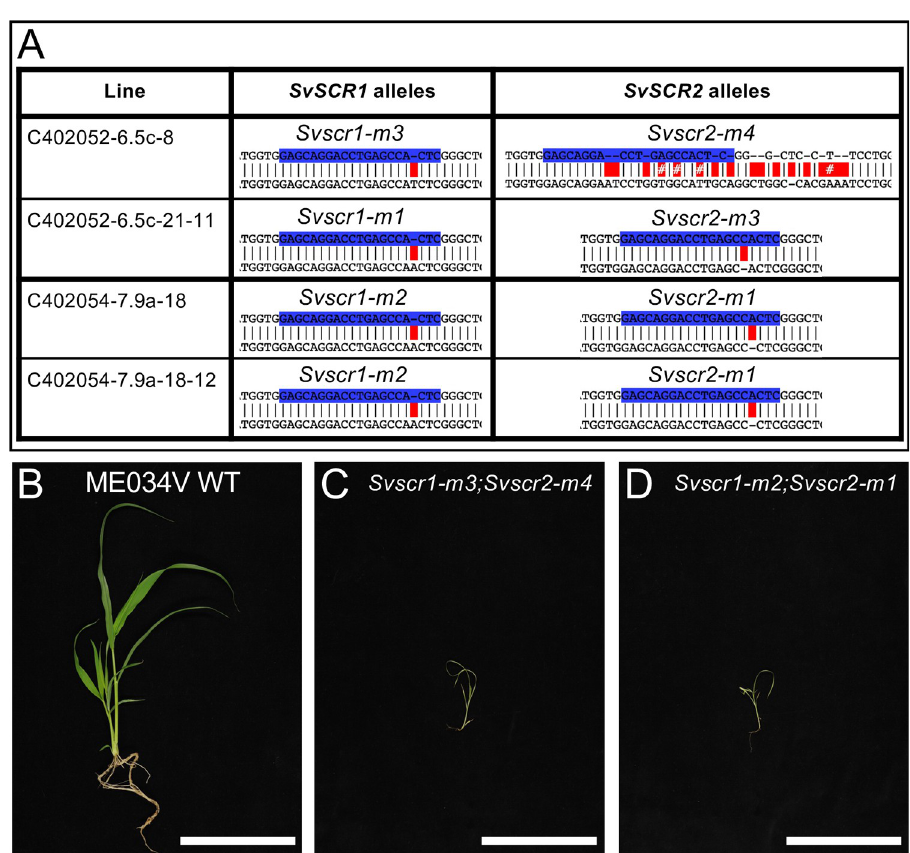
Fig 1. Mutations in SvSCR1 and SvSCR2 affect plant growth. A) Sequences of mutant Svscr1 and Svscr2 alleles in two independent lines (C402052-6 & C402054-7). Wild-type (WT) sequence is shown on top, with the sequence of the mutant allele shown beneath. Guide sequences are depicted in blue, and mismatches between the WT and mutant sequence indicated in red. B-D) Photos of WT ME034V (B), Svscr1-m3;Svscr2-m4 (C) and Svscr1-m2-Svscr2-m1 (D) plants taken 20 days after sowing. Scale bars: